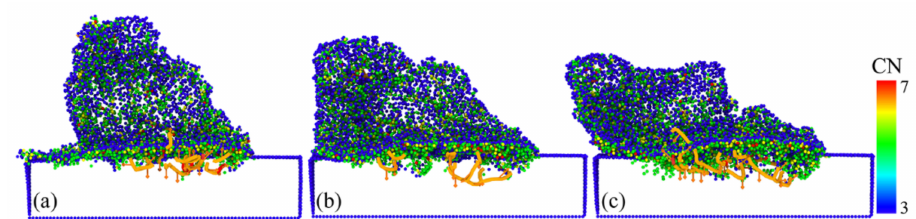
Figure 15. Cross-section of defect distribution after plowing by indenter with different radii of ( a ) 4.5 nm, ( b ) 6 nm and ( c ) 7 nm.